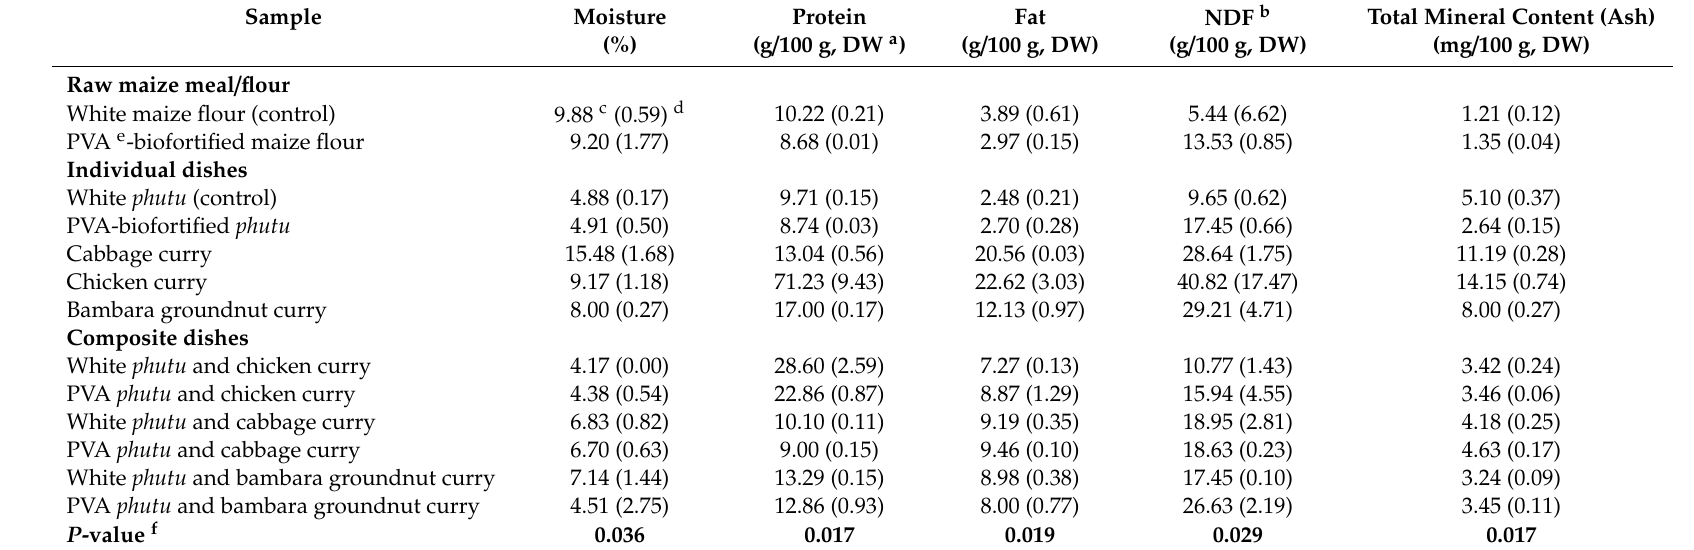
Table 1. Proximate composition of uncooked and cooked food samples except for sweet